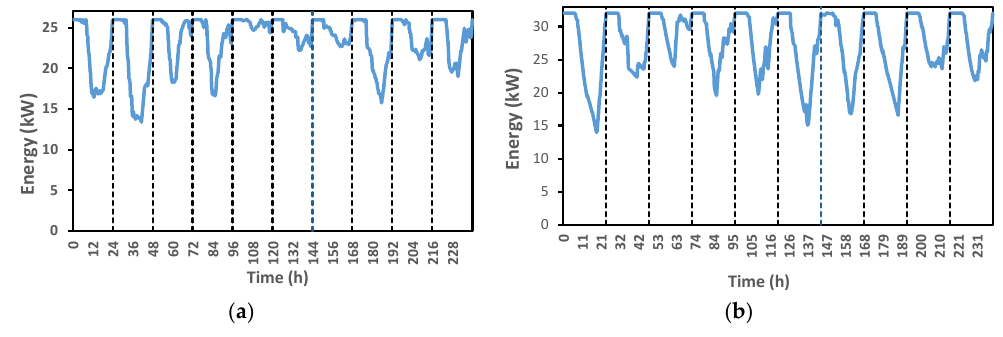
Figure 8. TES discharge profile for non-incentivised design: ( a ) detached house; ( b ) flat.